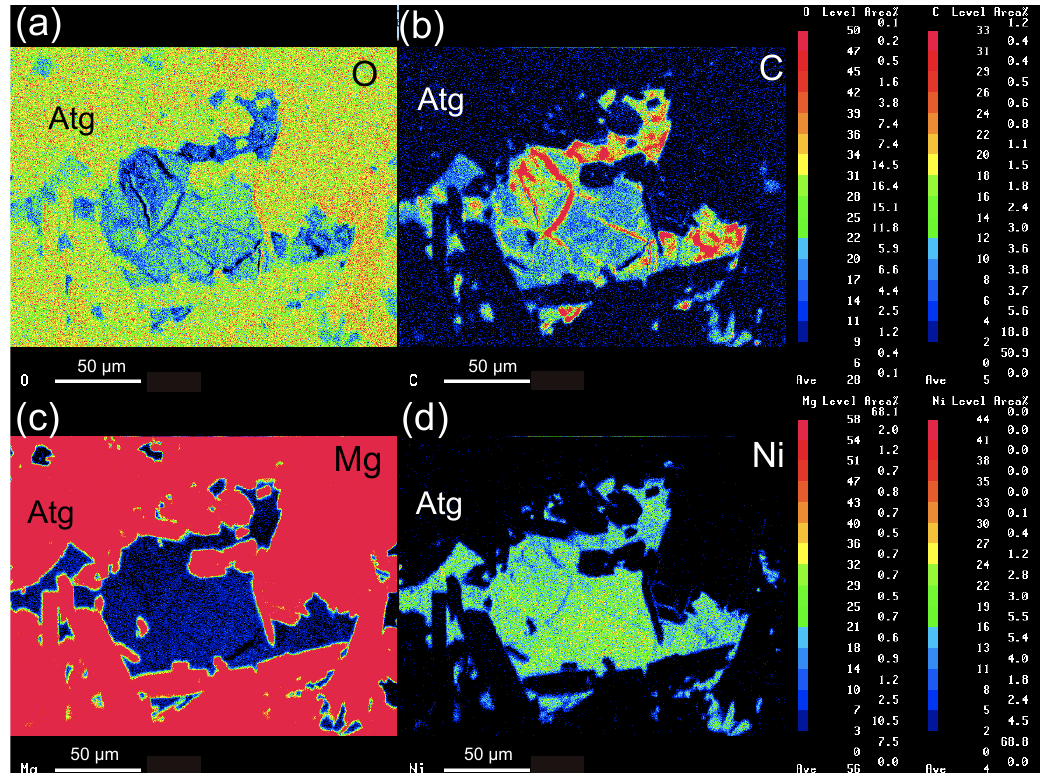
Figure 7. Distributions of elements (O, C, Mg and Ni) determined by microprobe in the zaratite-theophrastite aggregate and surroundings. The beam size was less than 1 (nominally 0) µ m across, and the scanning step was 1 µ m in microprobe analysis. The analyzed field is almost equivalent to that of Figure 3. Warmer colors represent higher contents than cooler colors. ( a ) O. Note that the low O content along fine cracks in the zaratite-theophrastite aggregate was due to remnants of carbon coating for previous microprobe analysis. ( b ) C. Note the sporadic high C contents (red to orange colors) due to incomplete cleaning of carbon coating for previous microprobe analysis. ( c ) Mg. Note the low and homogeneous Mg content in the aggregate. ( d ) Ni. Note the homogeneous Ni content in the aggregate.